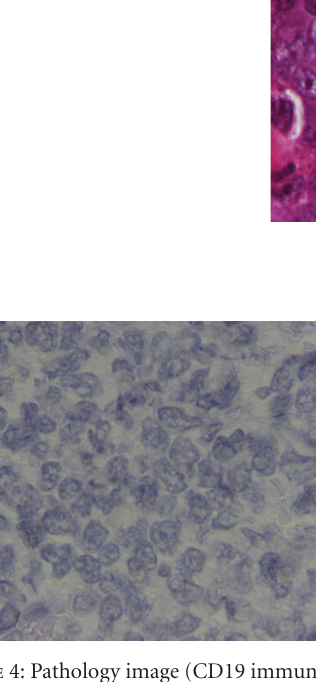
Figure 4: Pathology image (CD19 immunostain).